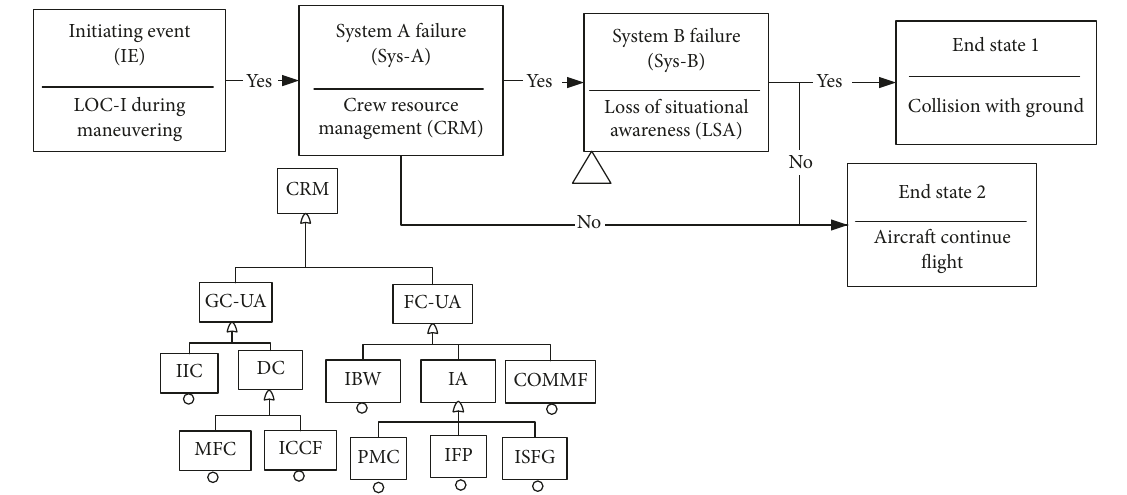
Figure 10: Example of hybrid